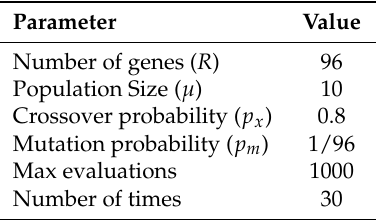
Table 2. Evolutionary algorithm parameters used to test our